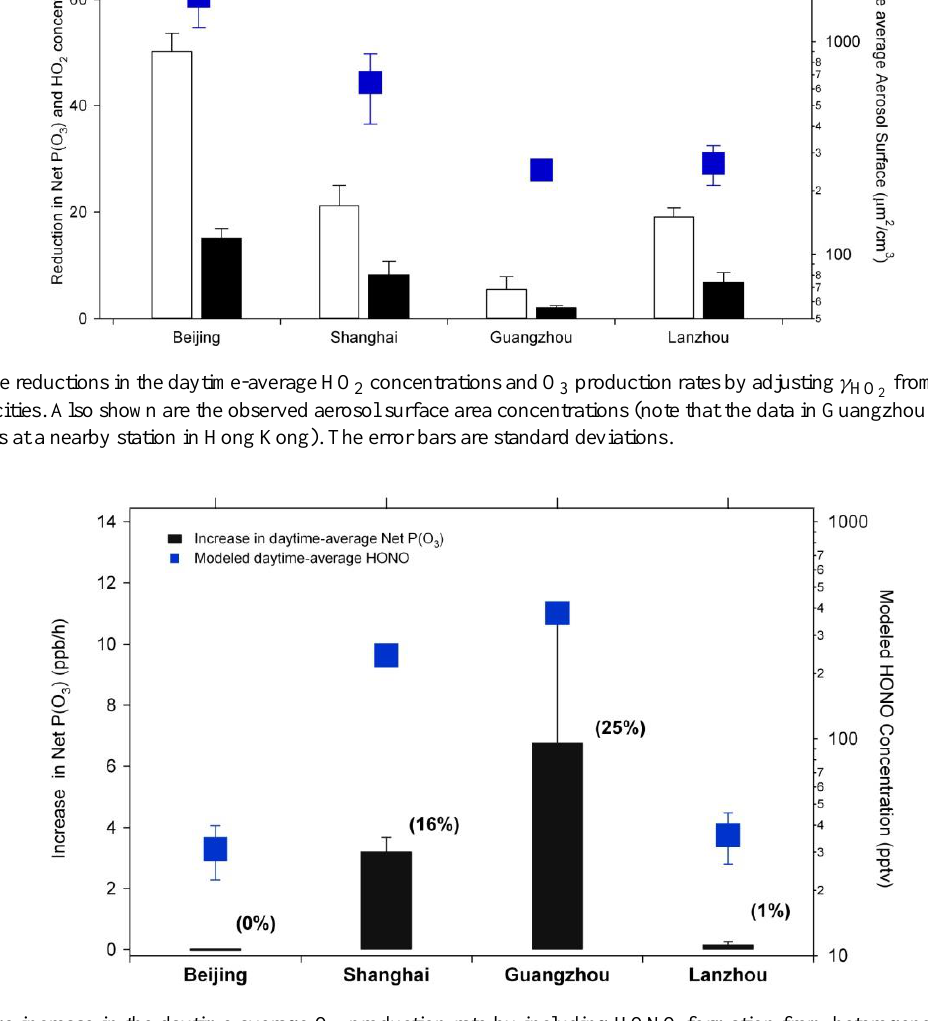
Figure 8. Average increase in the daytime-average O 3 production rate by including HONO formation from heterogeneous NO 2 reactions during episodes at four cities. Also shown are the modeled daytime-average HONO concentrations. The error bars are standard deviations. The number in parentheses gives the increase in